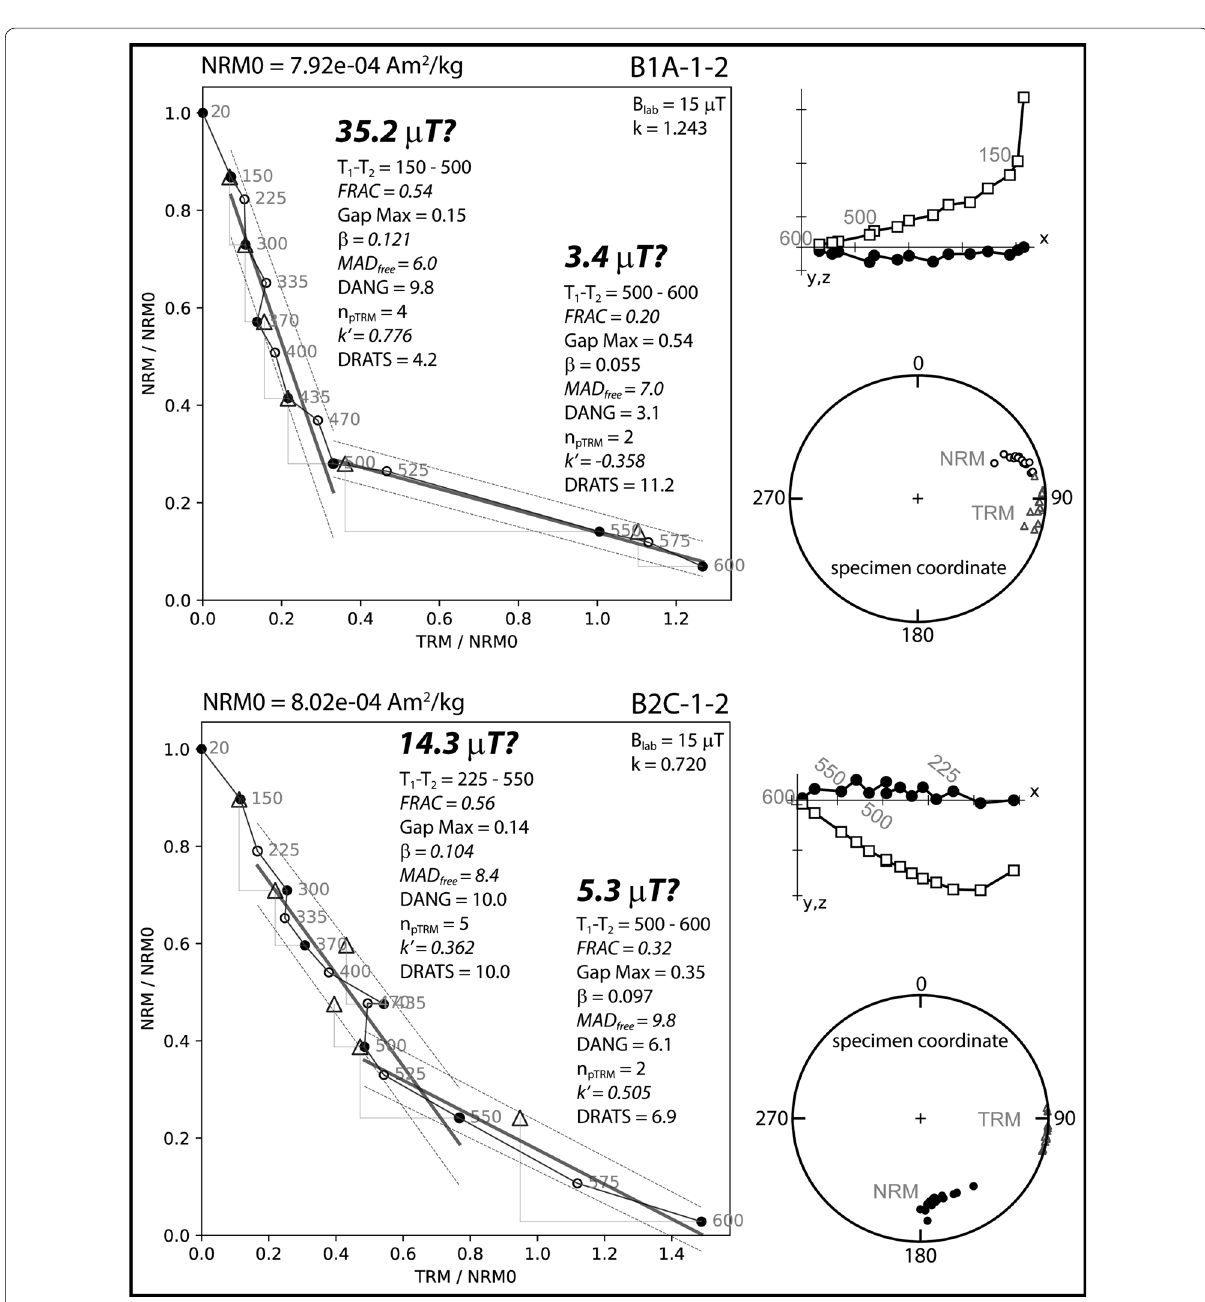
Fig. 5 Two examples of results of the IZZI‑Thellier API experiments. For each example, the Arai diagram (left‑hand), the orthogonal projection of the zero‑field steps (NRMs) (upper right‑hand), and the equal‑area projection of NRMs and laboratory‑induced TRMs in the specimen coordinate systems (lower right‑hand) are shown. In each Arai diagram, filled (open) circles represent the ZI (IZ) steps, triangles are the pTRM checks, and each green line and the two neighboring dotted lines are the best‑fit lines for each of the selected temperature steps and the associated threshold lines that define boundaries for the SCAT statistics (see Shaar and Tauxe 2013 for details). The Arai diagrams show curved (or kinked) patterns with different degrees of the curvature ( k 1.243 and k 0.720, respectively), resulting in obtaining no qualified API estimate when applying the = = conventional best‑fitting line technique. For each Arai diagram two examples of the best‑fitting line are shown with the associated statistical values (see text for details). For the orthogonal projection, filled circles (open squares) show projections of data at temperature steps on the y – x ( z – x ) plane and the x ‑axis is rotated to the horizontal direction of the initial NRM. For the equal‑area projection, circles (triangles) represent NRM (TRM) data at temperature steps and filled (open) symbols represent projection of data on the lower (upper)